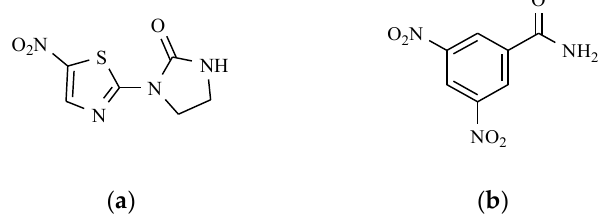
Figure 13. The chemical structures of 5-nitrothiazole: ( a ) Niridazole, and ( b ) Nitromide.